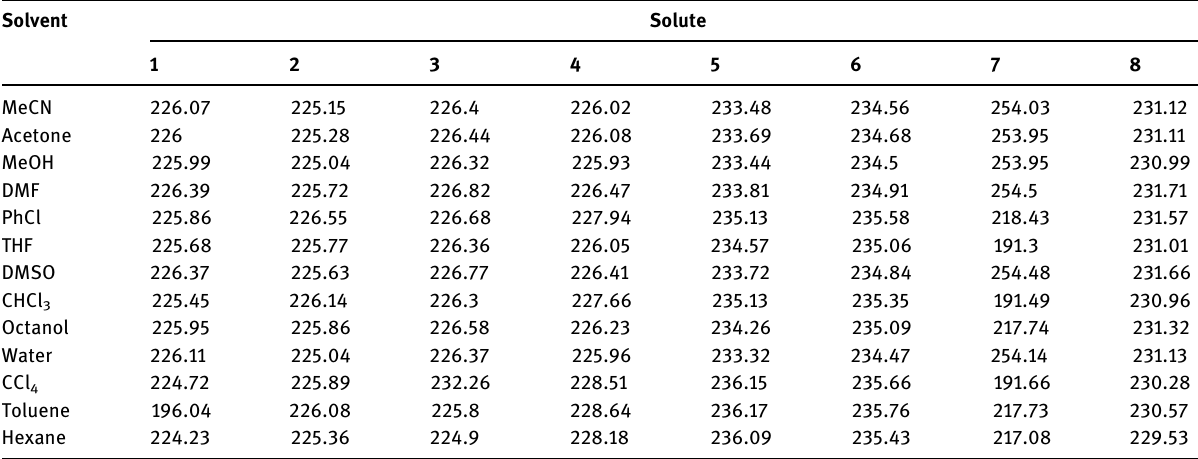
Table 7: Calculated values of λ max ( nm ) for azoles 1 – 8 at the CAM - B3LYP/6 - 311 ++ G ( 2d,3p ) //CAM - B3LYP/6 - 31G ( d,p ) level of theory using di ff erent solvents and PCM solvation